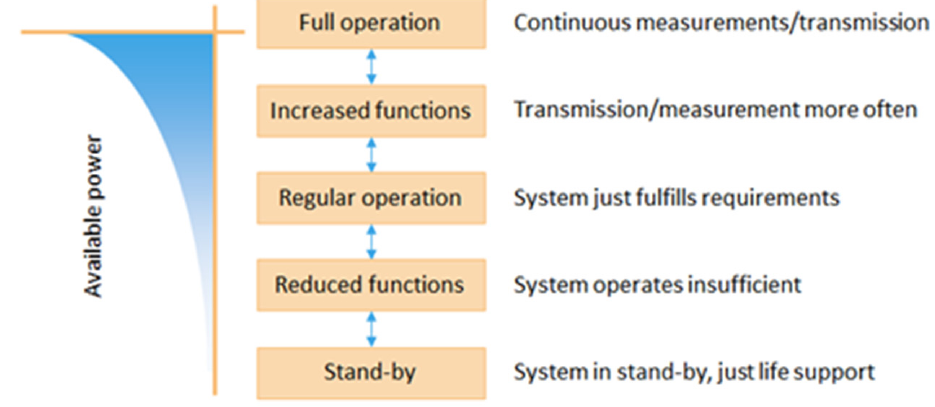
Figure 6. Operation states of a WSN with respect to energy.